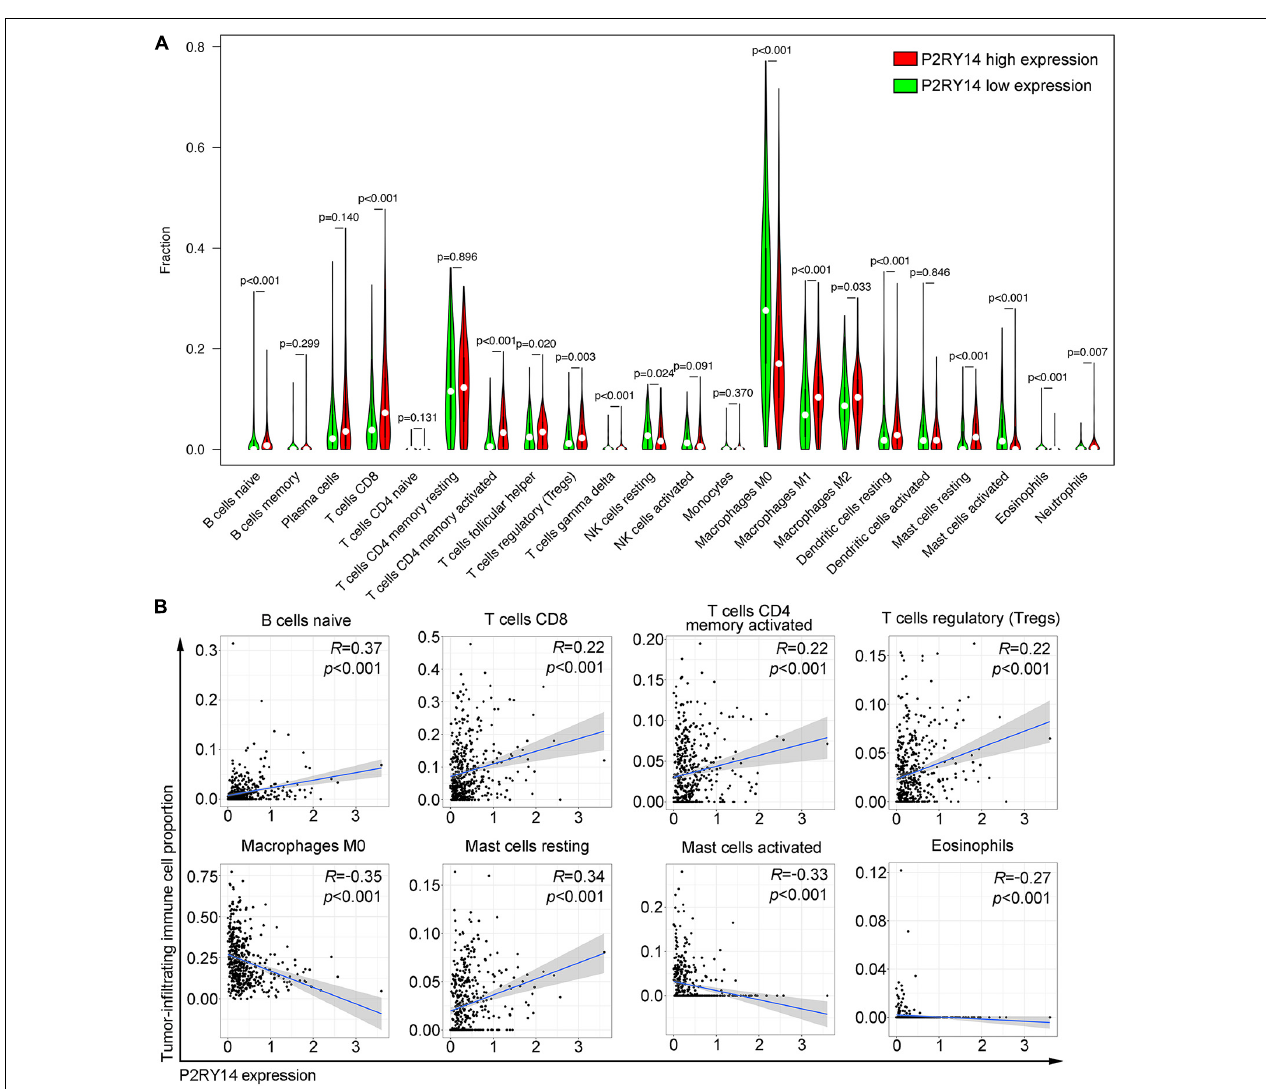
FIGURE 6 | Correlation of tumor-infiltrating immune cells proportion with P2RY14 expression. (A) Violin plots showing the ratio differentiation of 22 kinds of immune cells between HNSC tumor samples with high or low P2RY14 expression. (B) Scatter plot showing the correlation of eight kinds of tumor-infiltrating immune cells proportion with the P2RY14